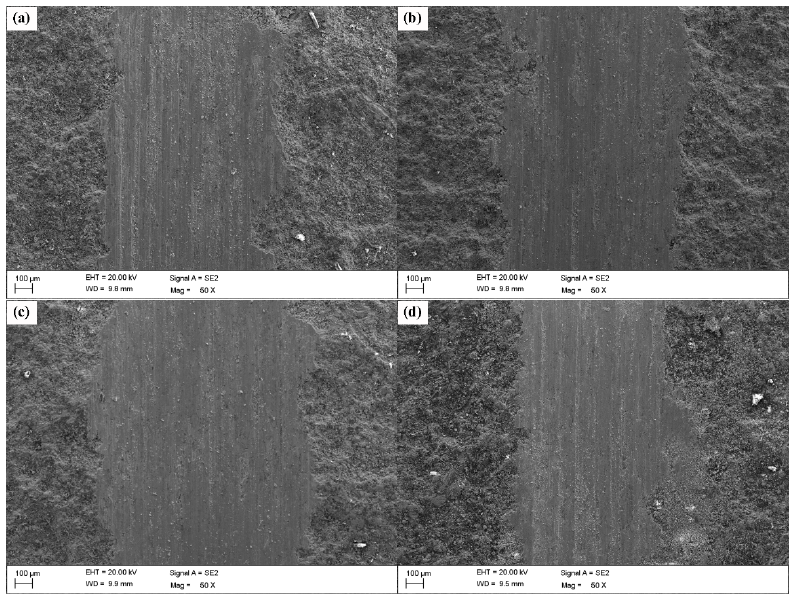
Figure 12. SEM images of the worn surfaces of the composite coatings with various Ni